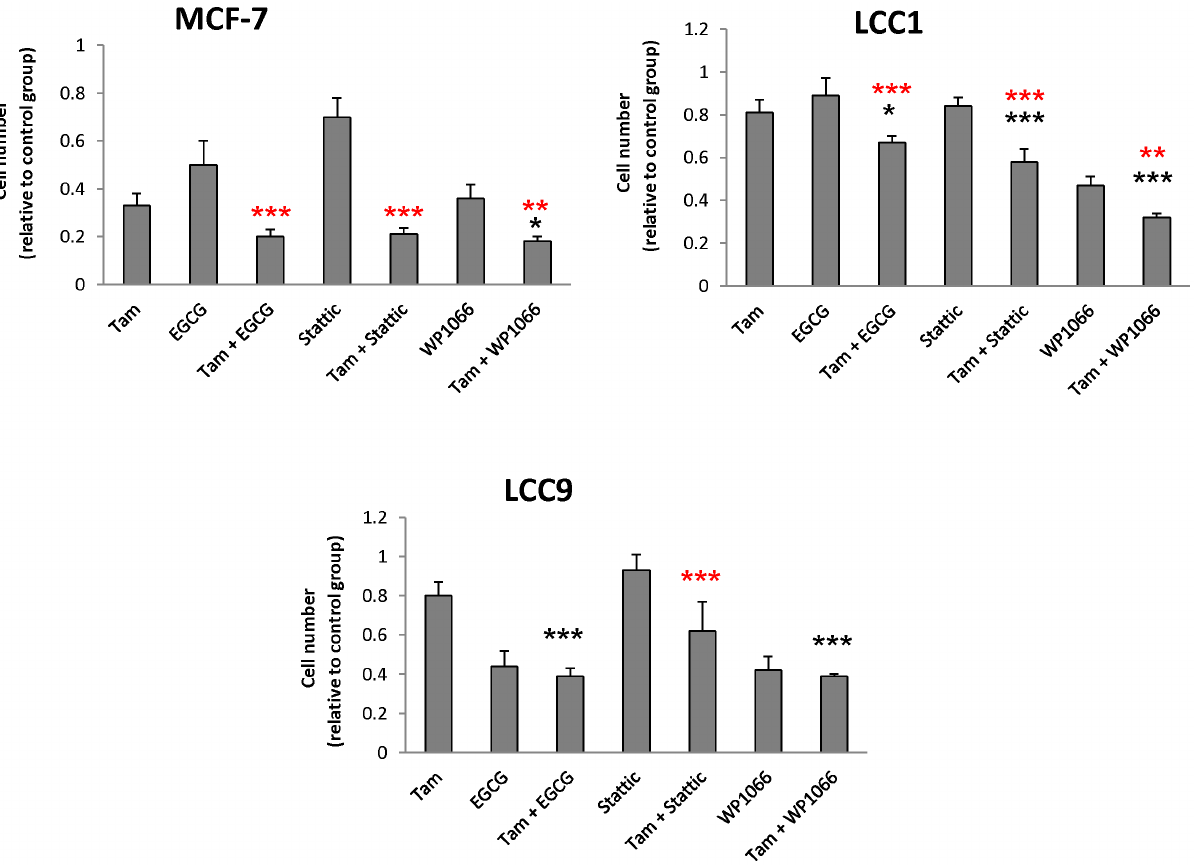
Figure 3. The effect of STAT inhibitors (EGCG, Stattic, or WP1066) combined with tamoxifen on MCF-7, MCF-7/LCC1 (LCC1), and MCF-7/LCC9 (LCC9) cells in the presence of estrogen. Cells were grown in charcoal-stripped serum, 48 h prior to treatment and were treated with control medium containing 1 nM E 2 , tamoxifen (1 m M) + E 2 (1 nM), EGCG (25 m M) + E 2 (1 nM), tamoxifen (1 m m) + EGCG (25 m m) + 1 nM E 2 , Stattic (0.5 m M) + E 2 (1 nM), tamoxifen (1 m M) + Stattic (0.5 m m) + E 2 (1 nM), WP1066 (2 m M) + E 2 (1 nM), tamoxifen (1 m M) + WP1066 (2 m M) + E 2 (1 nM) for 5 days. O.D. values were measured on day 5. Data were plotted as a mean inhibition ratio of O.D. values over untreated control groups + /- SD from 4 replicate samples. Asterisks represent significant changes between combined treatment and the inhibitor alone, while hashes represent differences between combined treatment and tamoxifen treatment alone. # / *P , 0.05, ## / **P , 0.01, ### / ***P , 0.001 (ANOVA followed by Tukey-Kramer).